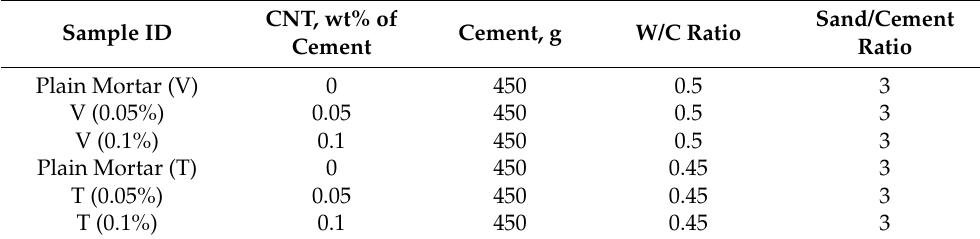
Table 3. Mix proportions of the CNTs-cementitious